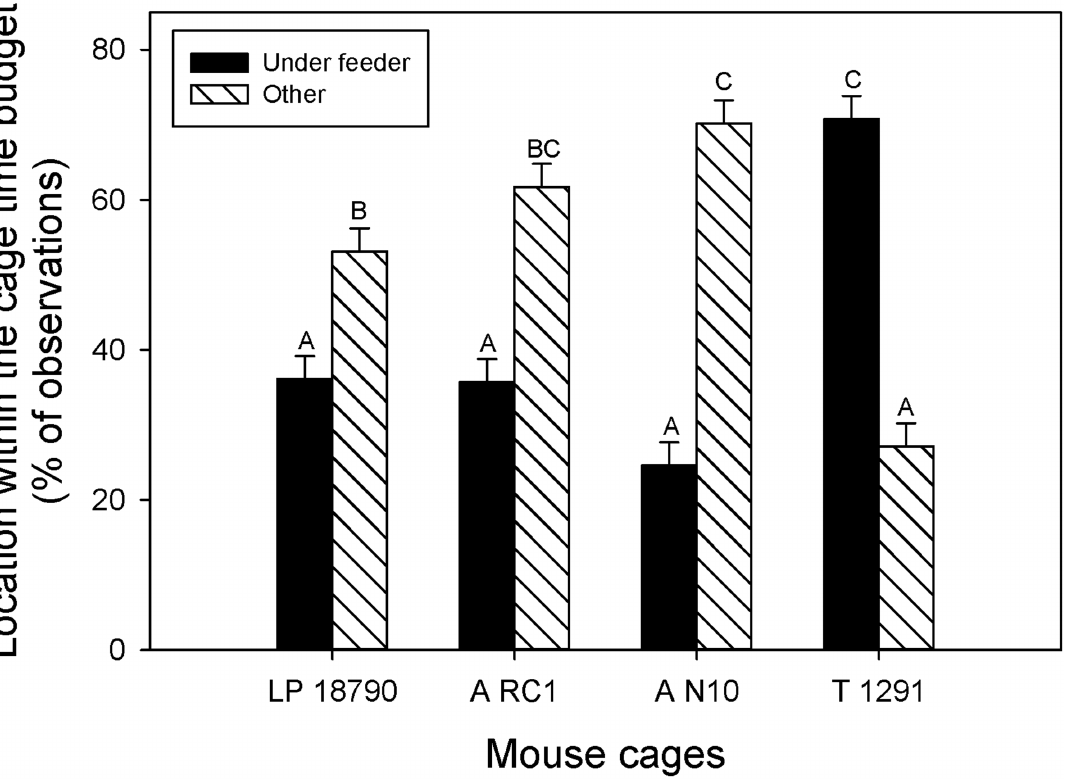
Fig 6. Location preference within the cage. Least square means and standard errors are plotted against the y-axis. Post hoc Tukey tests were considered significant if P < 0.05. Different letters indicate post hoc statistical differences.